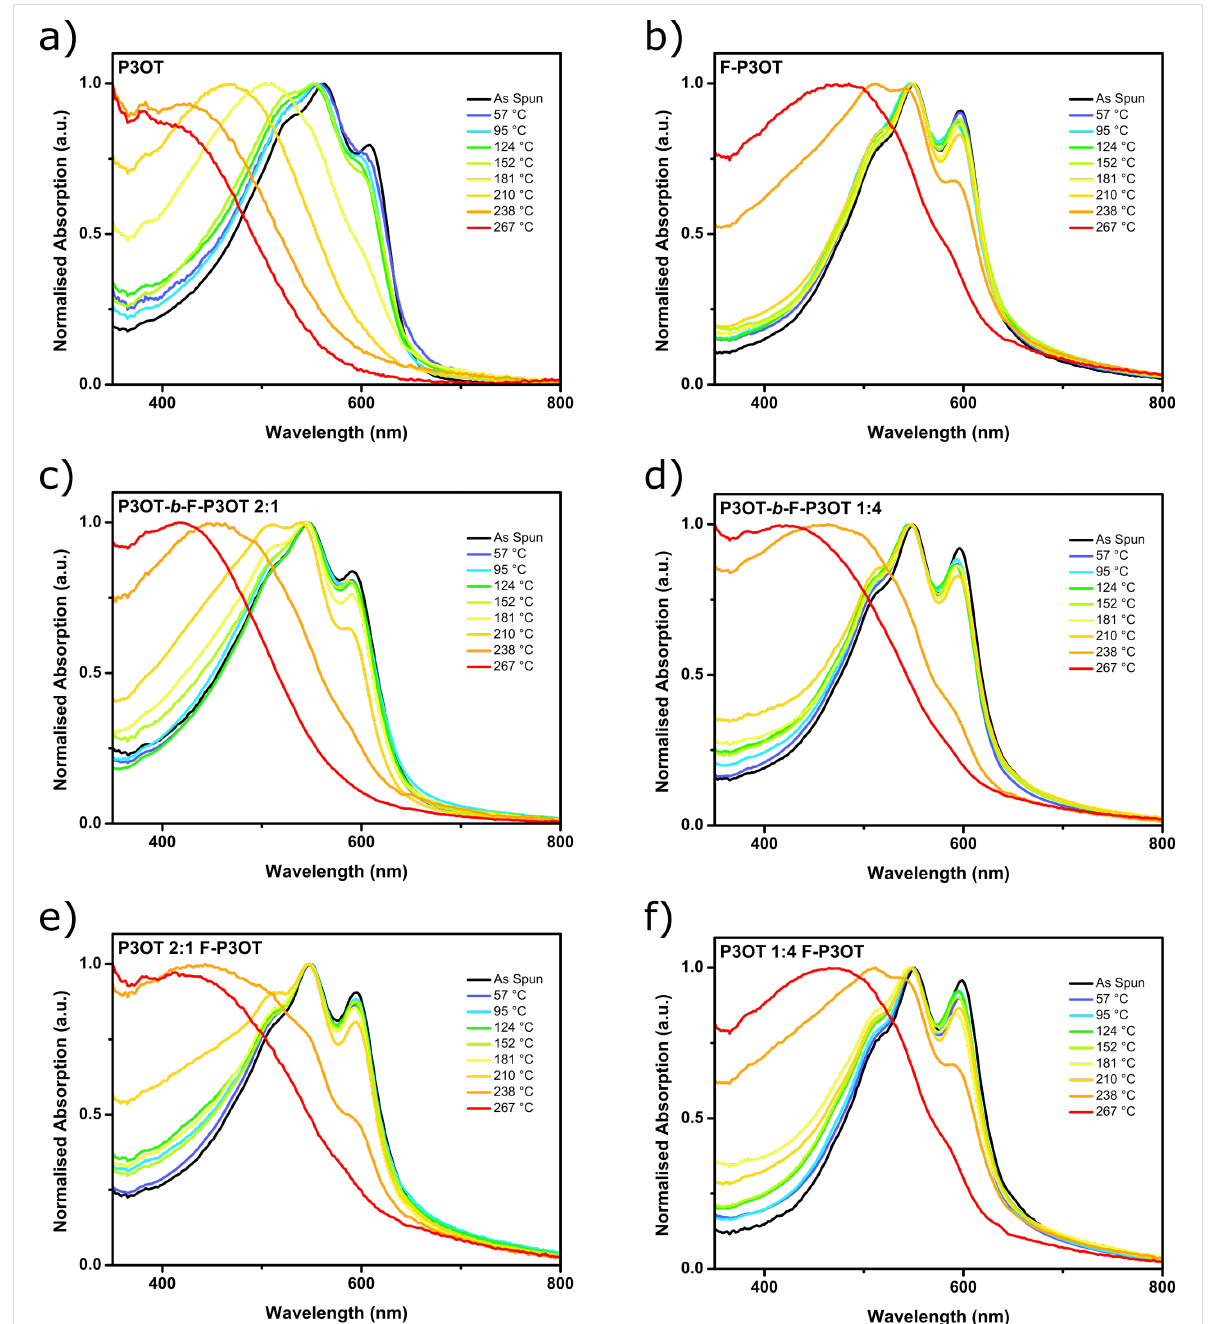
Figure 5: Thin-film UV–visible absorption spectra of a) P3OT, b) F-P3OT, c) P3OT- b -F-P3OT 2:1, d) P3OT- b -F-P3OT 4:1, e) P3OT/F-P3OT blend in a 2:1 ratio, and f) P3OT/F-P3OT blend in a 4:1 ratio. Films were annealed at the temperatures indicated for 20 min, then quench cooled and the UV–visible absorption spectrum measured. The same films were used for subsequent annealing at higher temperatures. Thin films were spin cast from hot 1,2,4-trichlorobenzene.